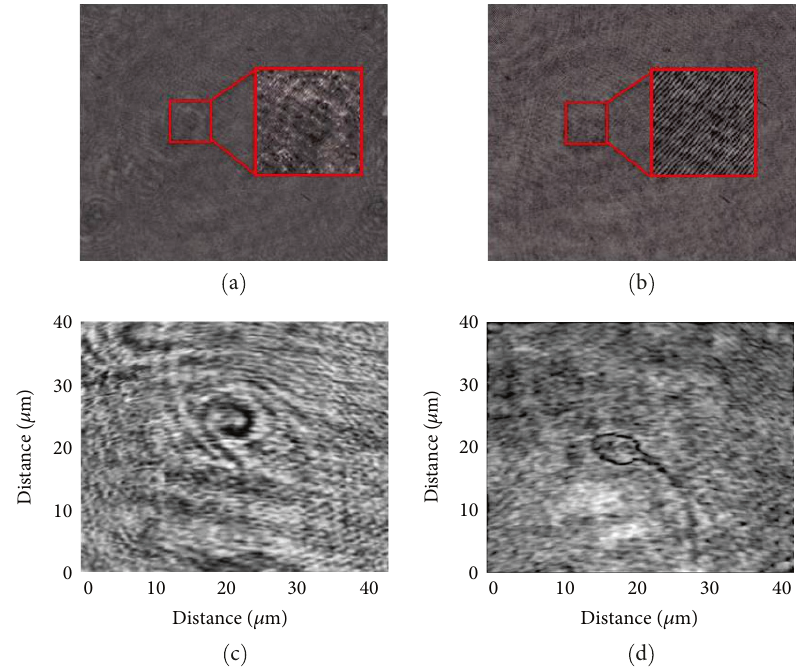
Figure 1: (a) Hologram of the sperm cell acquired out of focus. (b) Reference hologram acquired in the sperm cell proximity region. (c) Reconstructed amplitude map at the plane of acquisition. (d) Reconstructed amplitude map of the sperm cell region at the focus plane